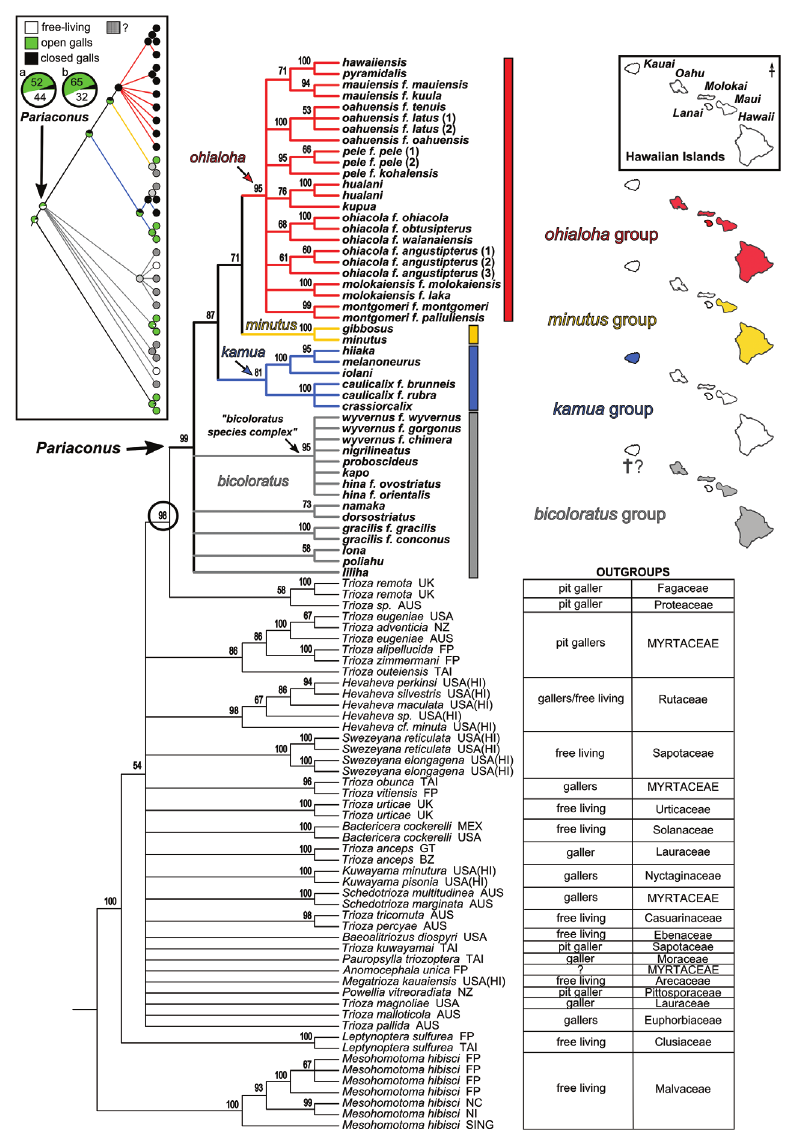
Figure 1. Results from outgroup sampling. Majority-rule consensus of maximum likelihood analysis (combined COI and cytB data using RAxML with 1000 bootstrap replicates) including Pariaconus (28 species) and putative outgroup taxa (36 species). The four recognized species groups within Pariaconus are indicated and their distribution in the Hawaiian Islands is shown. Outgroup biology and host plant family is given, with other Myrtaceae-feeding species highlighted. Strong support for Trioza remota ex Quercus (Palaearctic) and Trioza sp. ex Banksia (Australia) as the closest outgroups is indicated with a black circle. Inset top left, maximum likelihood ancestral character state reconstruction (character -lnL = -16.48) showing proportional likelihoods, and the ancestral state at the root node of Pariaconus with a) pit galling outgroup taxa monophyletic, and b) pit galling outgroup taxa